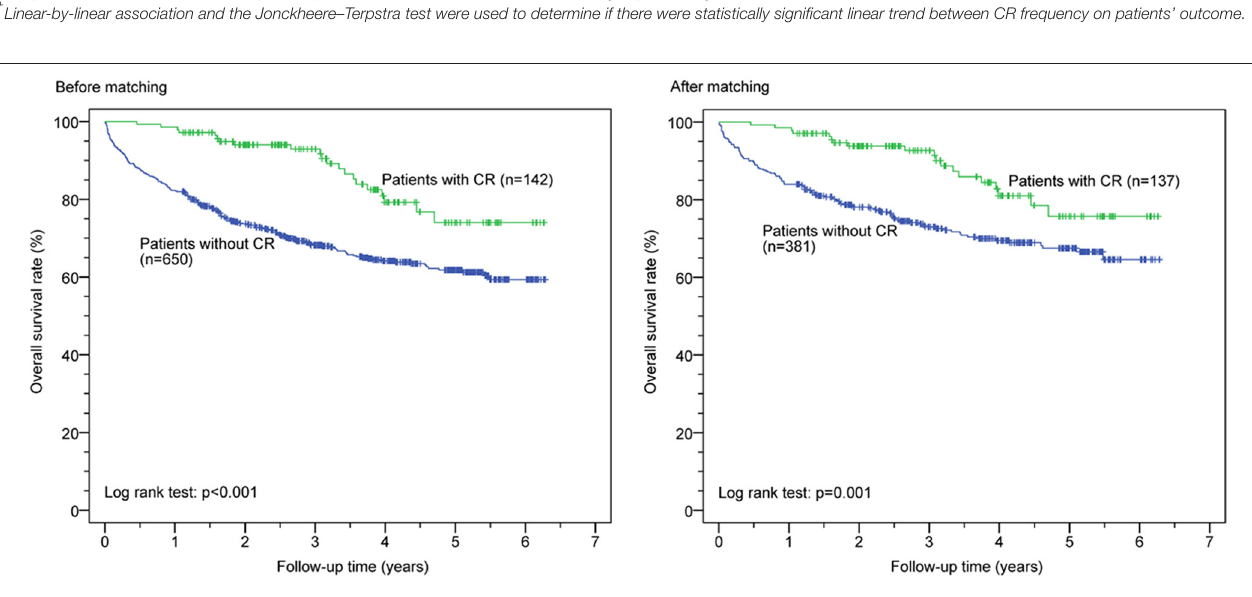
from the hospital) for CR are still unknown. As demonstrated in our study, patients who were discharged from hospital after HF had significant survival benefits when they received CR within 3